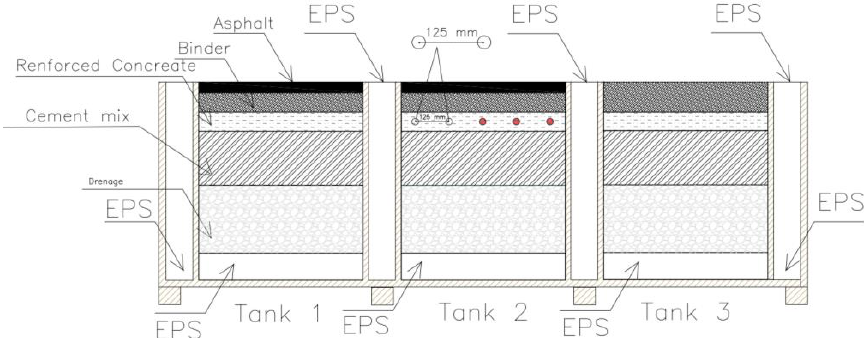
Figure 1. Experimental set-up schema configuration.